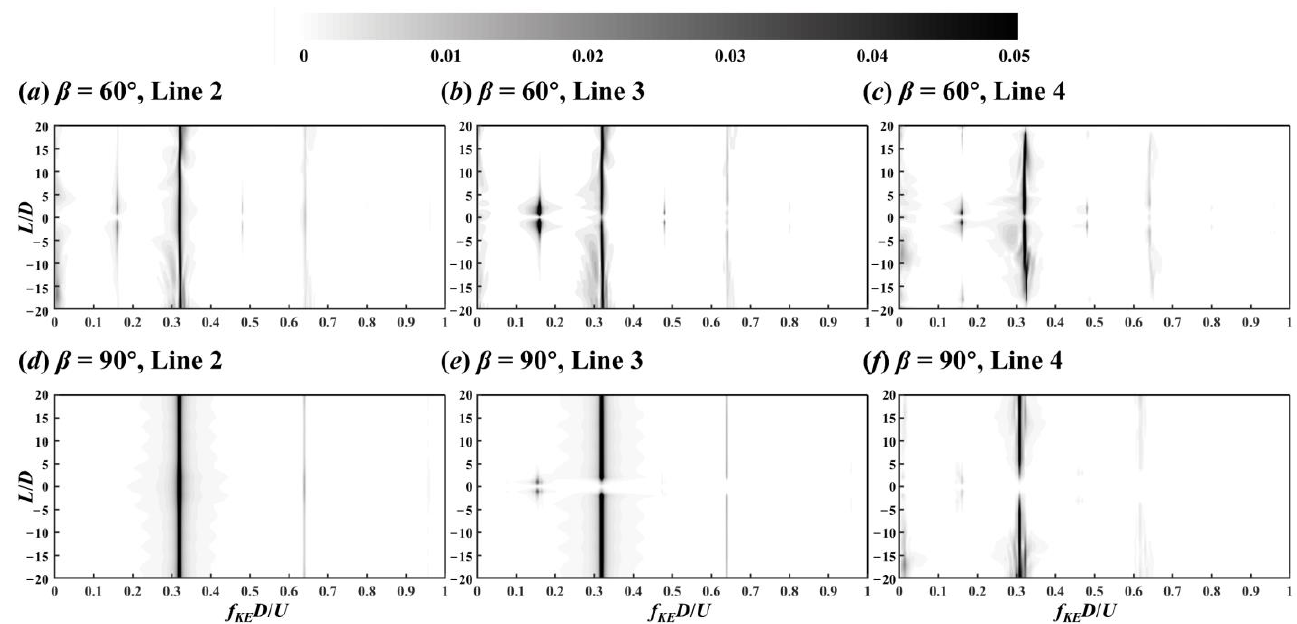
Figure 9. Contour of PSD calculated by the KE along line 1 in the wake of the single cylinder.